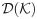
Clustering H-DNA data at [Na+] = 100 mM condition.(A) The scatter plots of (kL→H, kH→L) before (left) and after (right) applying VB-DCMM from [Na+] = 100 mM data. (B) The “average pairing distance” D(K) as a function of the number of clusters (K)(see Methods). The minimum value of D(K) is found at K=6. (C) Left: the scatter plot of clustered data projected on (kL→Hbf,kL→Haf) plane. Right: scatter plot of clustered data projected on (kH→Lbf,kH→Laf) plane. The data belonging to different clusters are depicted in different colors, and the centroid of each cluster is marked with the × symbol. Total 98 data points were used for analysis. (D) The result of the above clustering is represented using 6 kinetic arrows which represent the centroids of each cluster represented in (kL→H, kH→L) plane. The starting point of the arrow is (〈kL→H(μ),bf〉, 〈kH→L(μ),bf〉) whereas the ending point of the arrow is (〈kL→H(μ),af〉, 〈kH→L(μ),af〉), where the superscript μ represents the index of each cluster μ = 1, 2, … 6. The colors used for depicting kinetic arrows are consistent with the data points in (C). (E) A schematic of the conformational landscape of H-DNA.